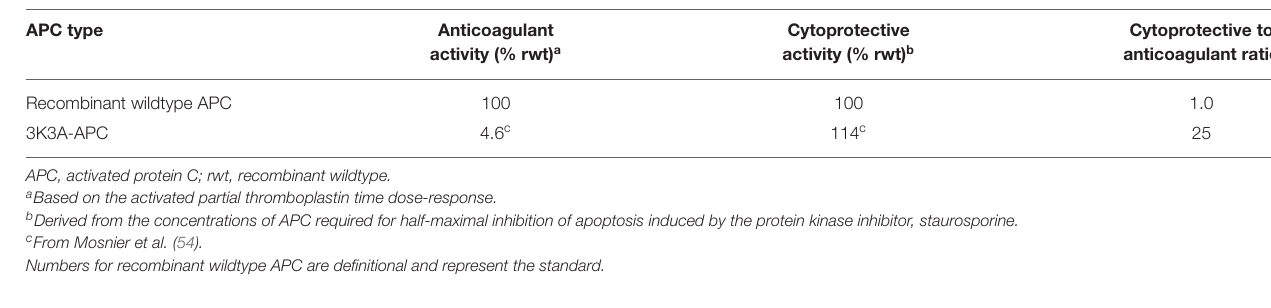
TABLE 3 | Cytoprotective and anticoagulant activity of recombinant wildtype APC vs.